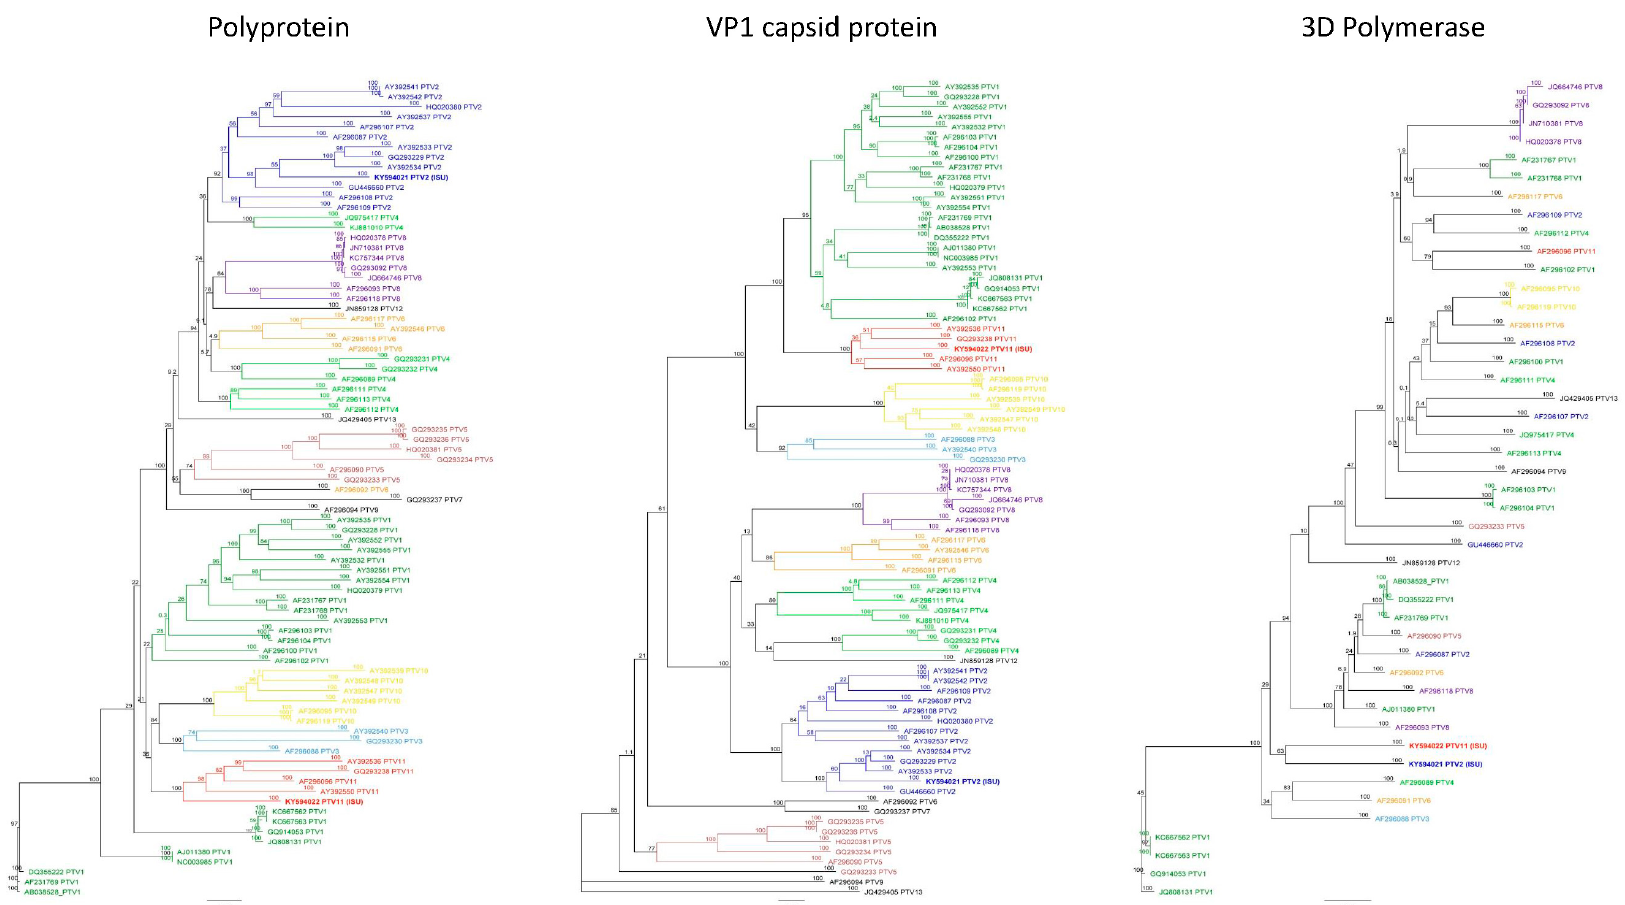
Figure 1. Phylogenetic trees illustrating the genetic relation of 79 unique polyprotein sequences with isolates PTV-2 USA/IA65463/2014 and PTV-11 USA/IA09592/2013. Polyprotein phylogenetic tree ( A ); Major capsid protein (VP1) gene phylogenetic tree ( B ); 3D pol phylogenetic tree illustrating the genetic relation of 43 unique 3D gene sequences with isolates PTV-2 USA/IA65463/2014 and PTV-11 USA/IA09592/2013 ( C ). Branch distances expressed as percent of homology. Scale bar represents substitutions per site.